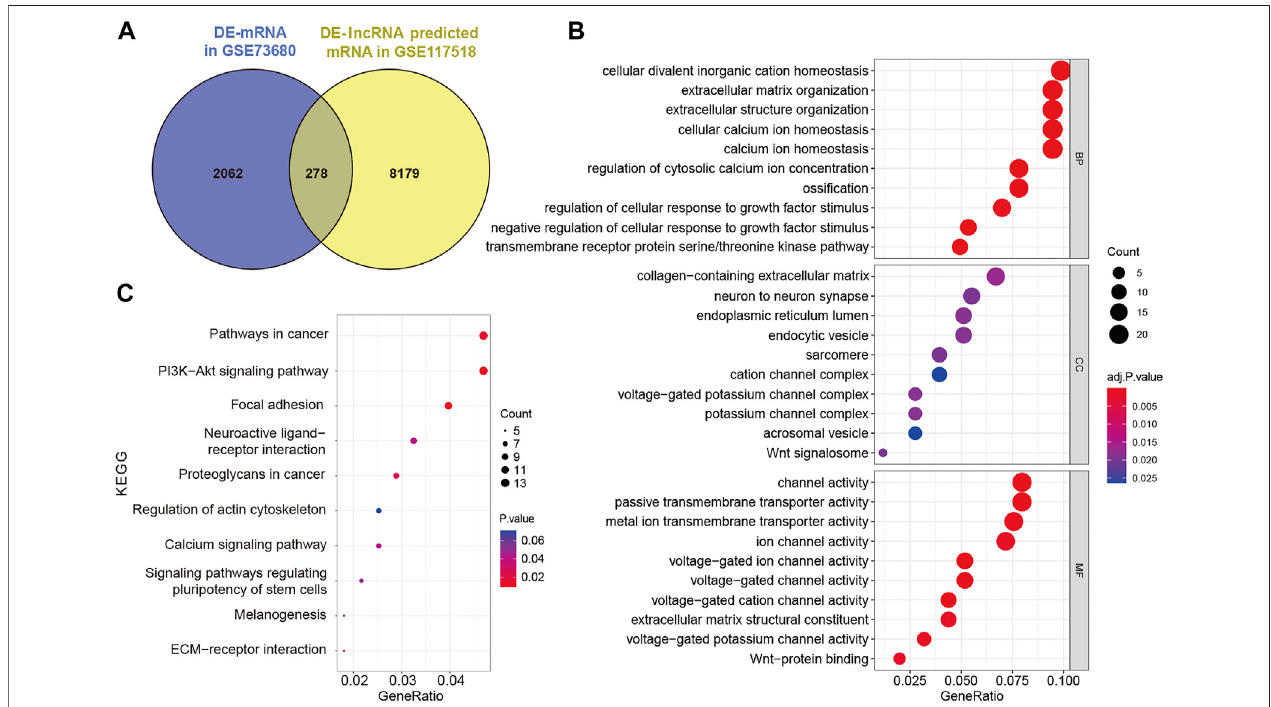
FIGURE 3 | Identi fi cation and analysis of lncRNA-related DE-mRNAs. (A) Intersection between DE-mRNAs and DE-lncRNAs predicted mRNAs. (B) GO enrichment analysis of lncRNA-related DE-mRNAs. (C) KEGG enrichment analysis of lncRNA-related DE-mRNAs. DE-mRNAs, differentially expressed mRNAs; DE- lncRNAs, differentially expressed lncRNAs; GO, gene ontology; and KEGG, Kyoto Encyclopedia of Genes and